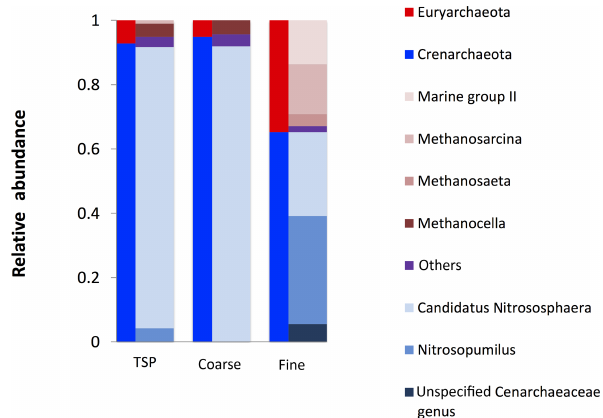
Figure 1. Archaeal community composition for total suspended (TSP), the same airstream split into coarse, and fine particulate mat- ter on the level of phyla (red/blue) and genera (pastel